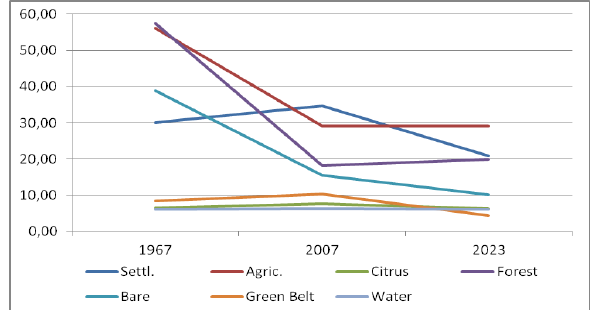
Figure 9. Edge Density (ED) metrics.